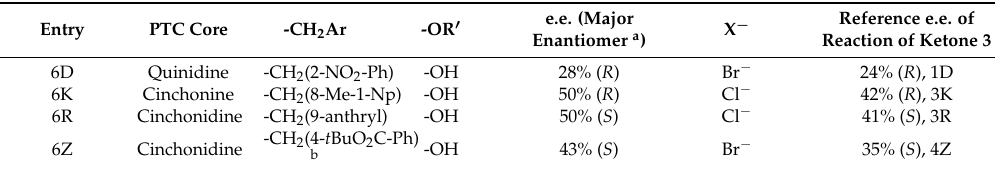
Table 3. PTC Reactions of Unsaturated Ketone 9